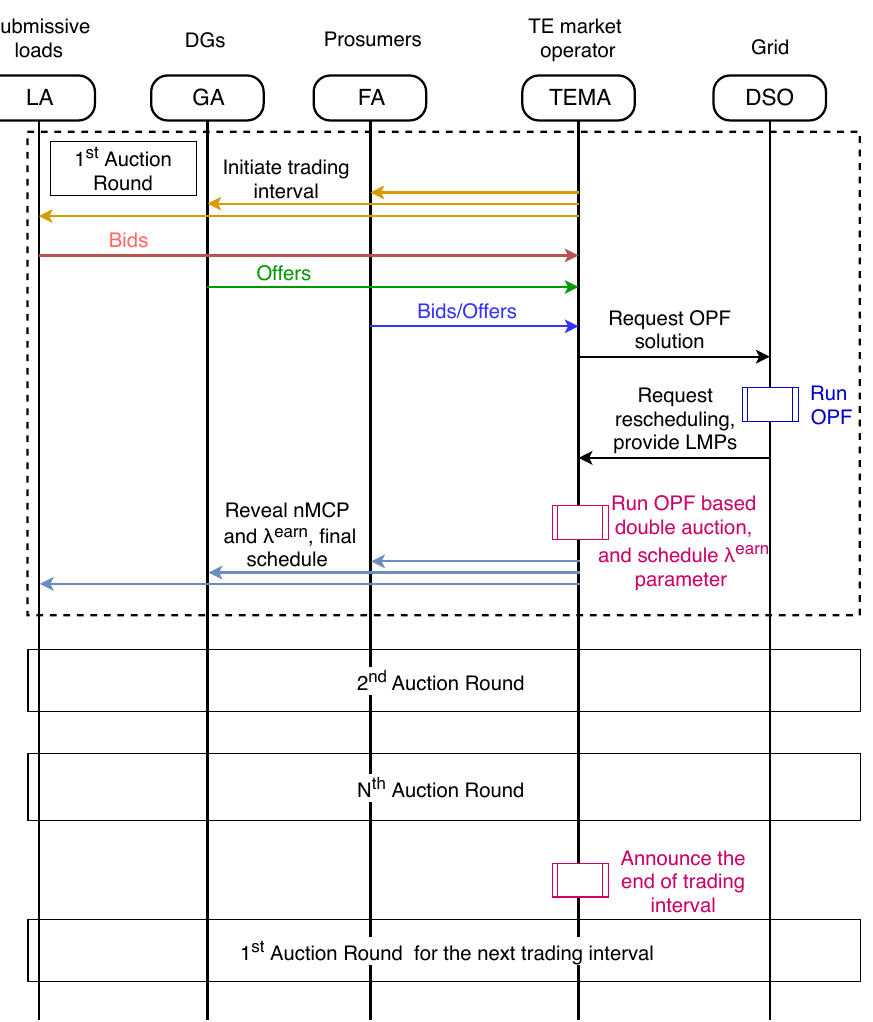
Figure 1. Multi-agent based transactive energy (TE) management framework with renewable en- ergy sources.